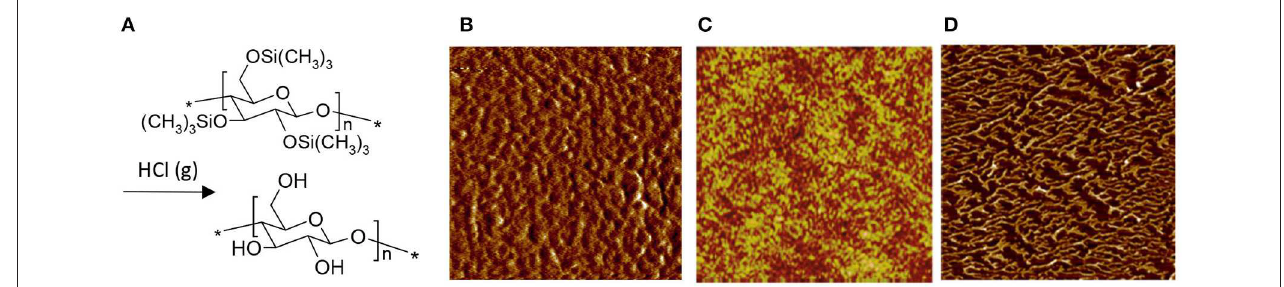
FIGURE 3 | (A) Reaction scheme of TMSC conversion to cellulose with HCl vapor; AFM images of (B) spin coated cellulose film, regenerated from TMSC (Reproduced from Kontturi et al., 2003a with permission from American Chemical Society), (C) Langmuir-Schaefer deposited cellulose film, regenerated from TMSC (Reproduced from Aulin et al., 2009 with permission from American Chemical Society) and (D) Langmuir-Schaefer deposited cellulose monolayer on hydrophobized silica, regenerated from TMSC (Reproduced from Niinivaara and Kontturi, 2014 with permission from Royal Society of Chemistry). All images are 1 × 1 µ m 2